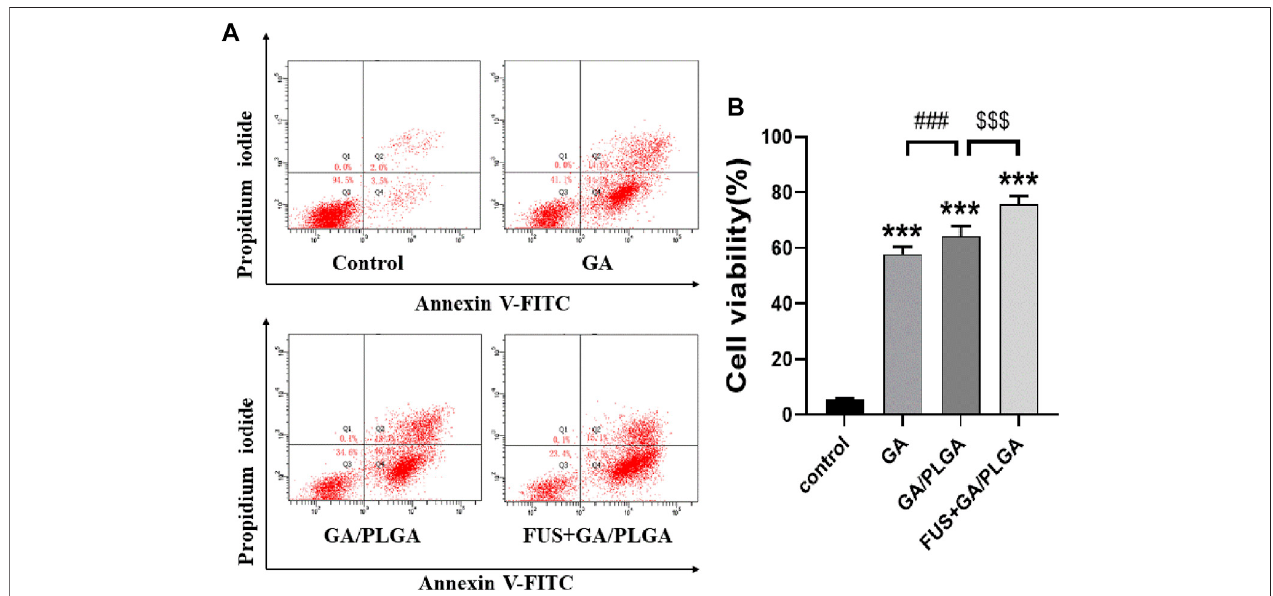
FIGURE 5 | (A) The apoptosis test of U251 cells. (B) The apoptosis rate of U251 cells. U251 cells were subjected to different treatments for 24 h; fl ow cytometry detected apoptotic rates in each group. The apoptotic rate of U251 cells in the FUS + GA/PLGA group was 75.97 ± 0.49% (*** p < 0.001 versus the control group and $$$ p < 0.001 versus the GA/PLGA